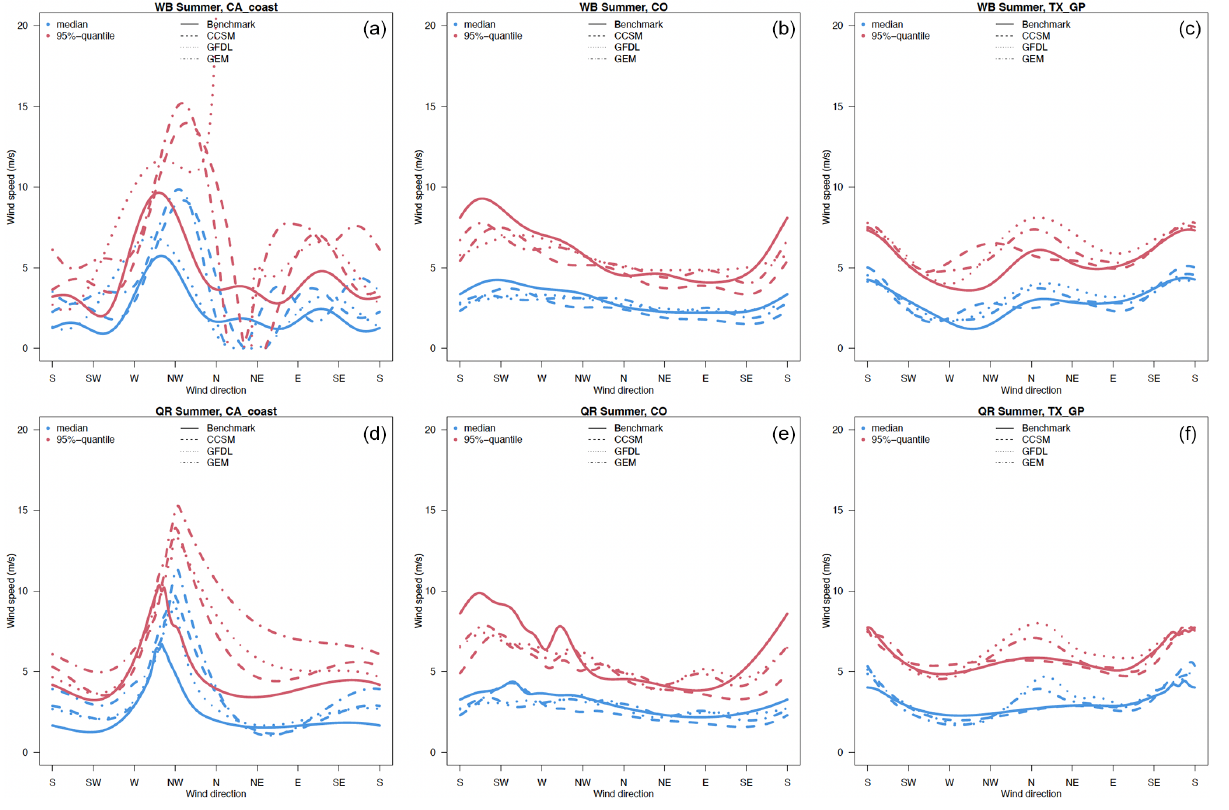
Figure 7. As in Fig. 6 but for summer.